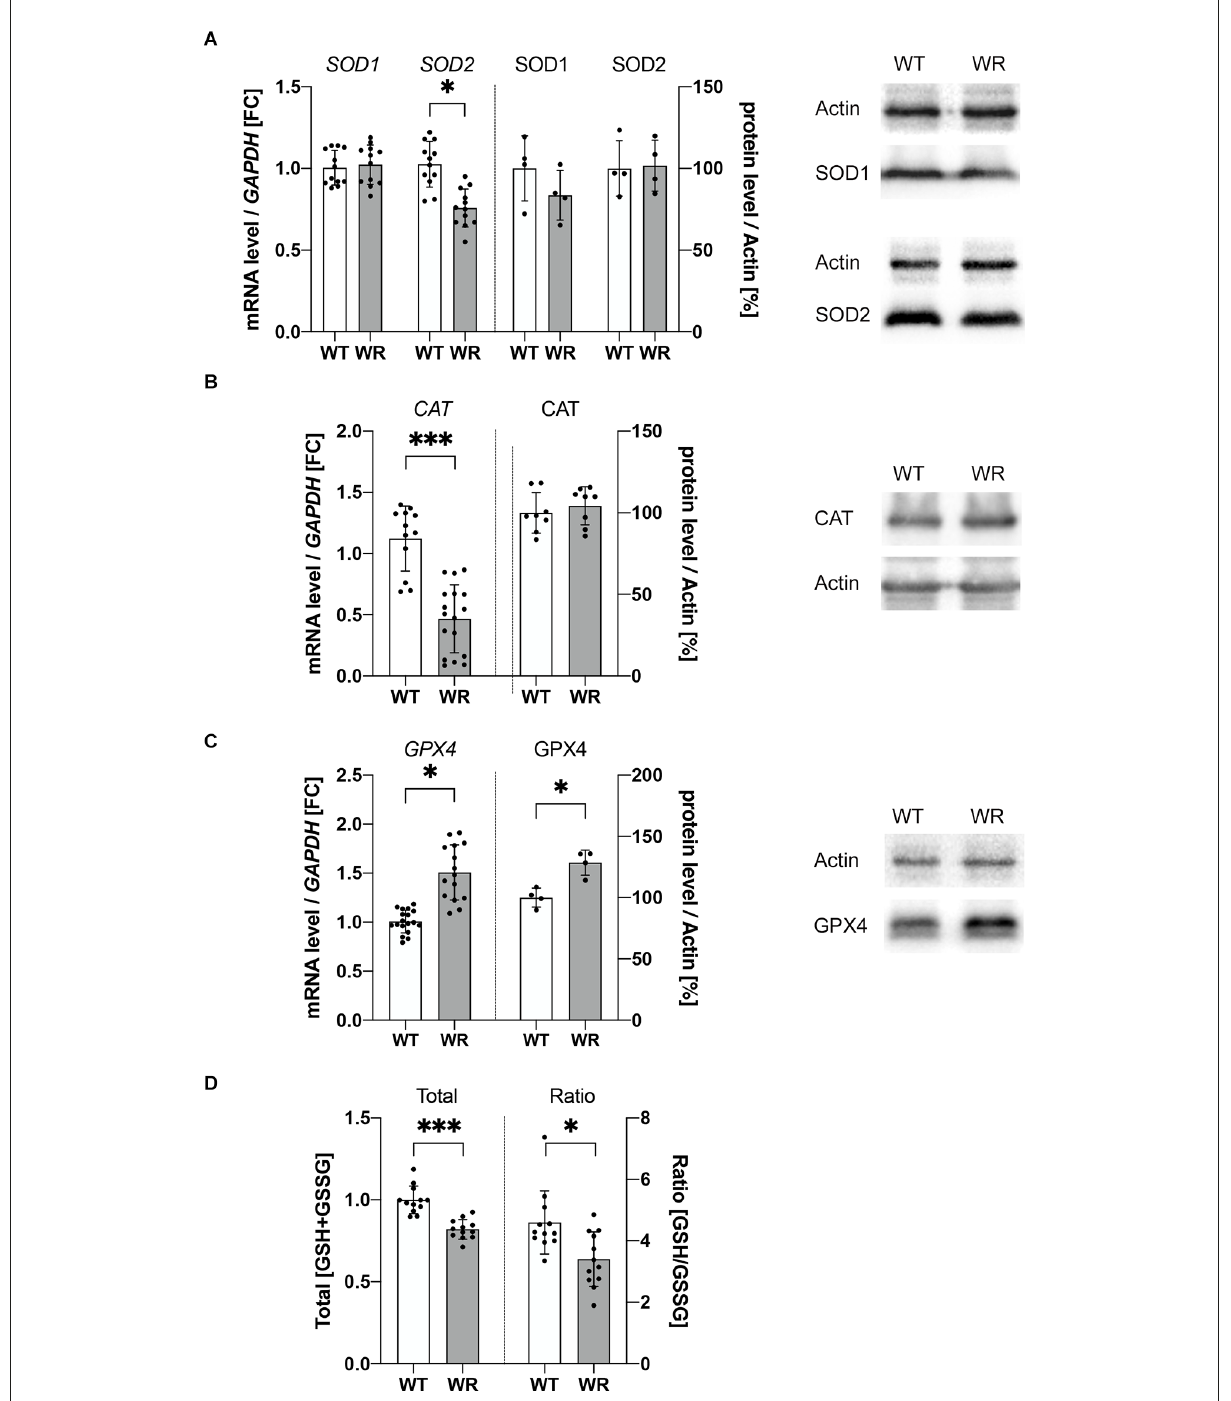
FIGURE3 Dysregulated expression of ROS detoxifying molecules in cervical Wobbler spinal cord. (A–C) mRNA and protein expression levels of SOD1 and 2 (A) , CAT (B) , and GPX4 (C) at stable clinical stage (p40) in cervical spinal cord of wild-type (WT) and Wobbler (WR) mouse. For relative quantification of mRNA level, the 2 − ∆∆ Ct method was conducted using GAPDH for normalization. For semiquantitative analysis of protein expression levels, arithmetic analysis of the band intensity with ImageJ 1.53f51 (National Institute of Health, USA) software was used. Band intensities of proteins of interest were normalized to the housekeeper actin. Normalized protein levels were compared between different genotypes. All data are presented as the mean values ± SD including individual data points, and Student’s t-test was performed for significance testing between WT and WR. Significant differences are indicated by ∗ p < 0.05, ∗∗∗ p < 0.001, n (qPCR) = 5; n (WB) = 4–8. (D) The total amount